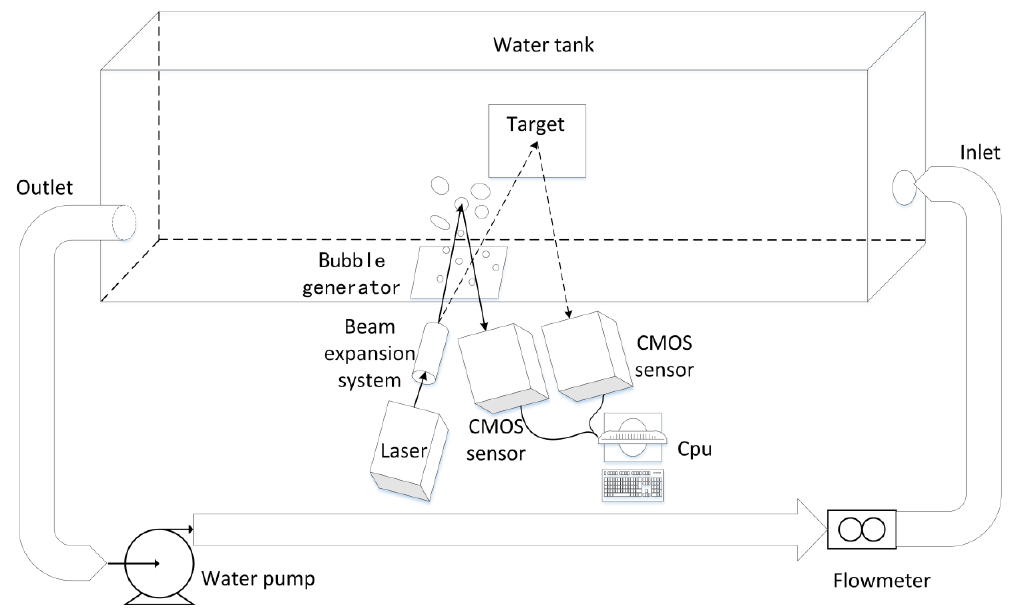
Figure 1. Stereoscopic structure diagram of laboratory experimental system.